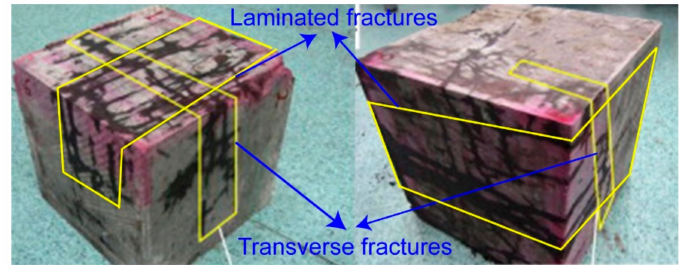
Figure 5. Hydraulic fractures after hydraulic fracturing of a shale specimen (after Guo et al.